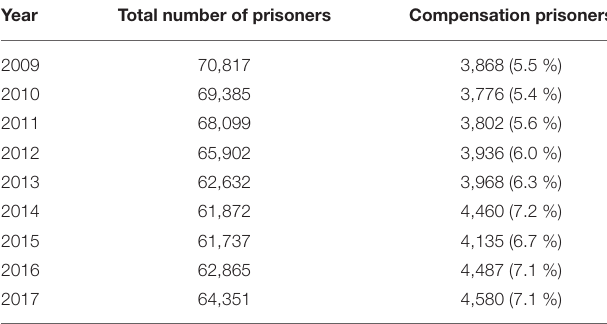
TABLE 2 | Number of prisoners in